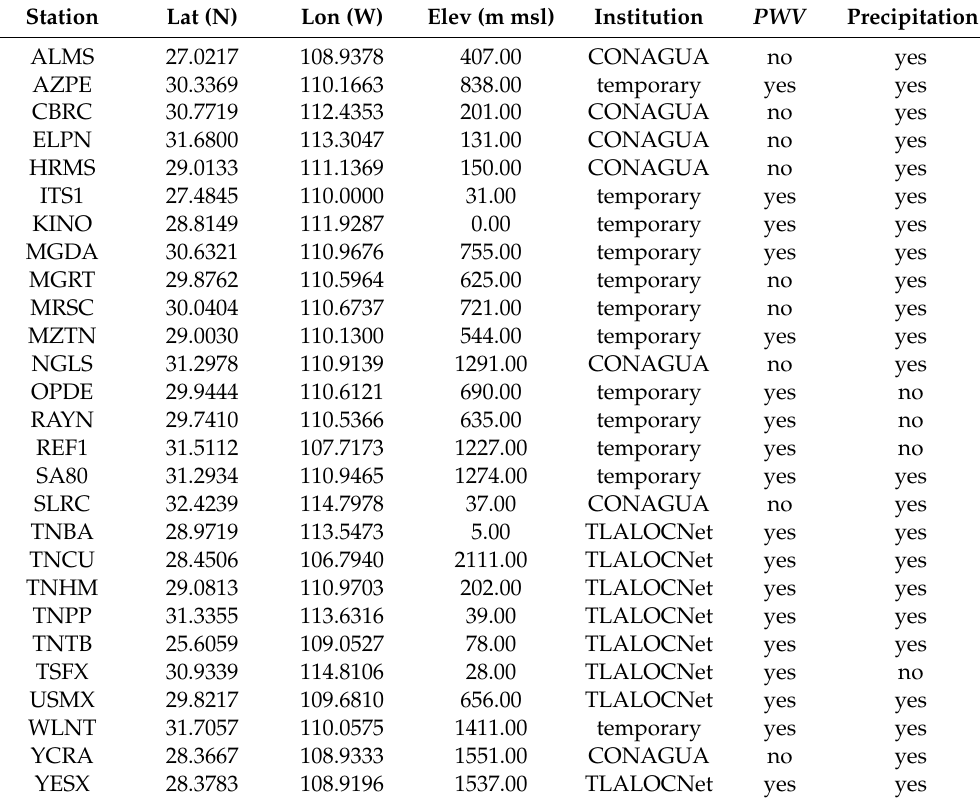
Table 1. List of observation sites during GPS Hydromet 2017 field campaign. The list includes station names, latitudes, longitudes, elevations, managing institutions, and observed data available. The managing institutions include Comisi ó n Nacional del Agua (CONAGUA) and Trans-boundary Land and Atmosphere Long-term Observational and Collaborative Network (TLALOCNet).